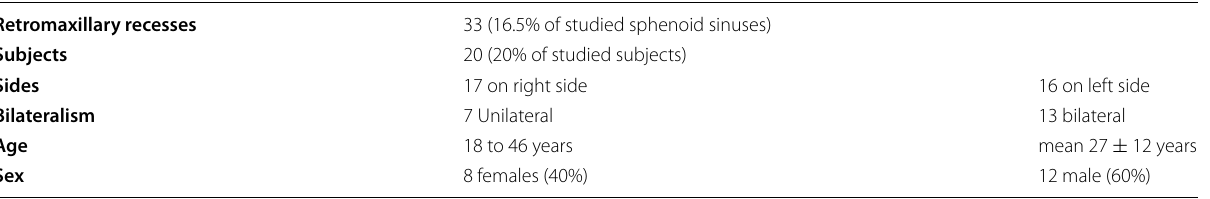
Table 1 Retromaxillary recessed detected in 100 studied subjects (200 sphenoid sinuses) Retromaxillary recesses